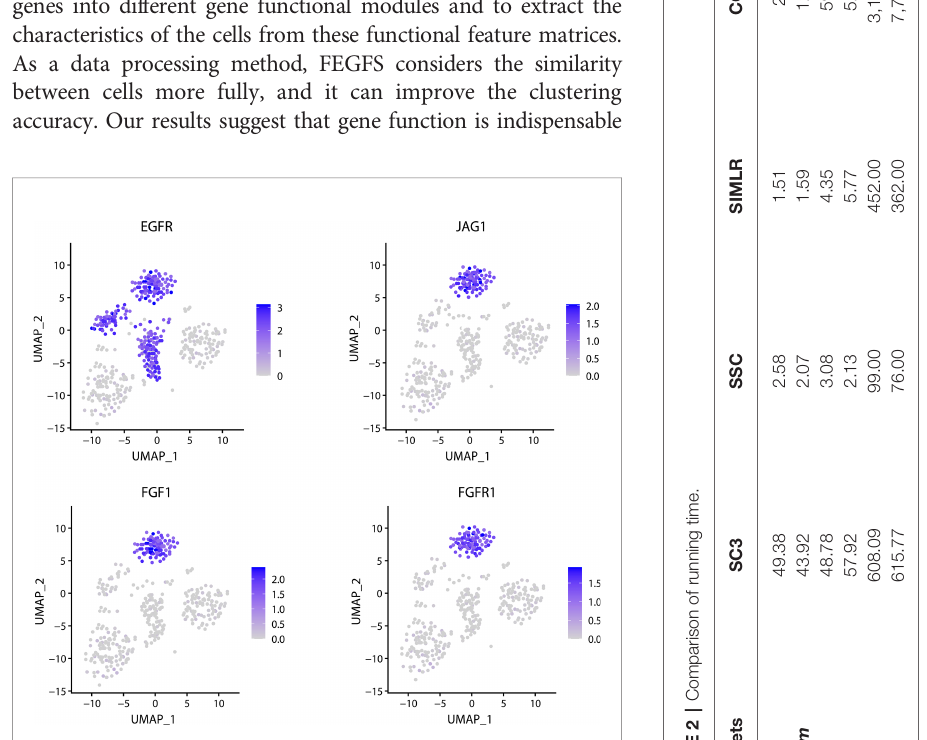
FIGURE 5 | Related gene expression distribution in glioma